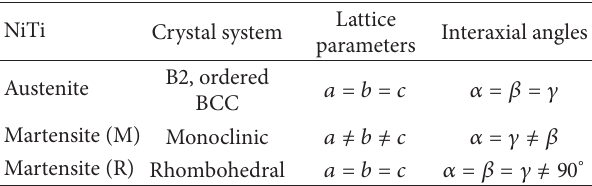
Table 1: Different phases of equiatomic NiTi shape memory alloy, crystal system, lattice parameters, and interaxial angles.